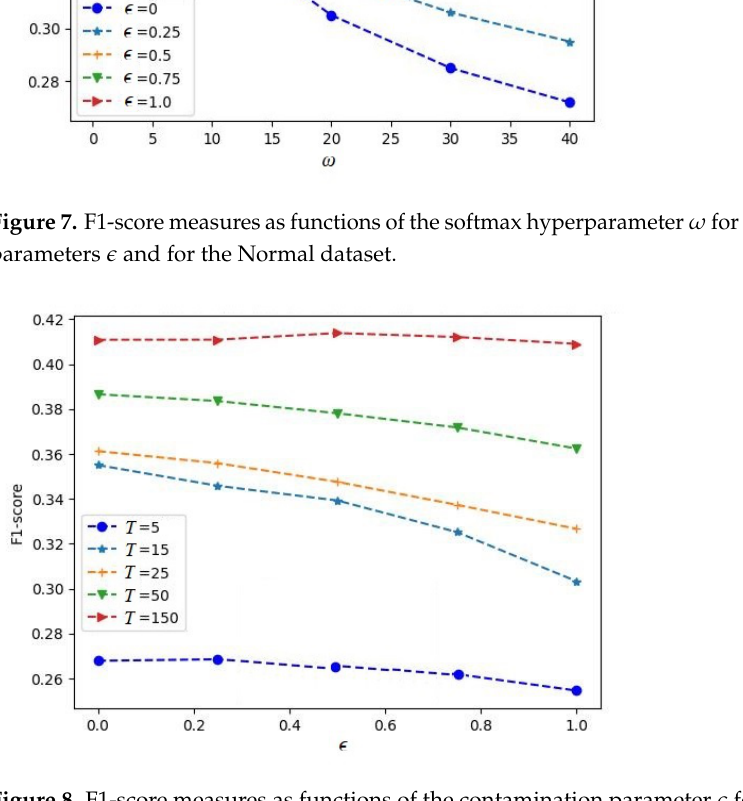
Figure 8. F1-score measures as functions of the contamination parameter (cid:101) for different numbers of trees in iForest T for the Circle